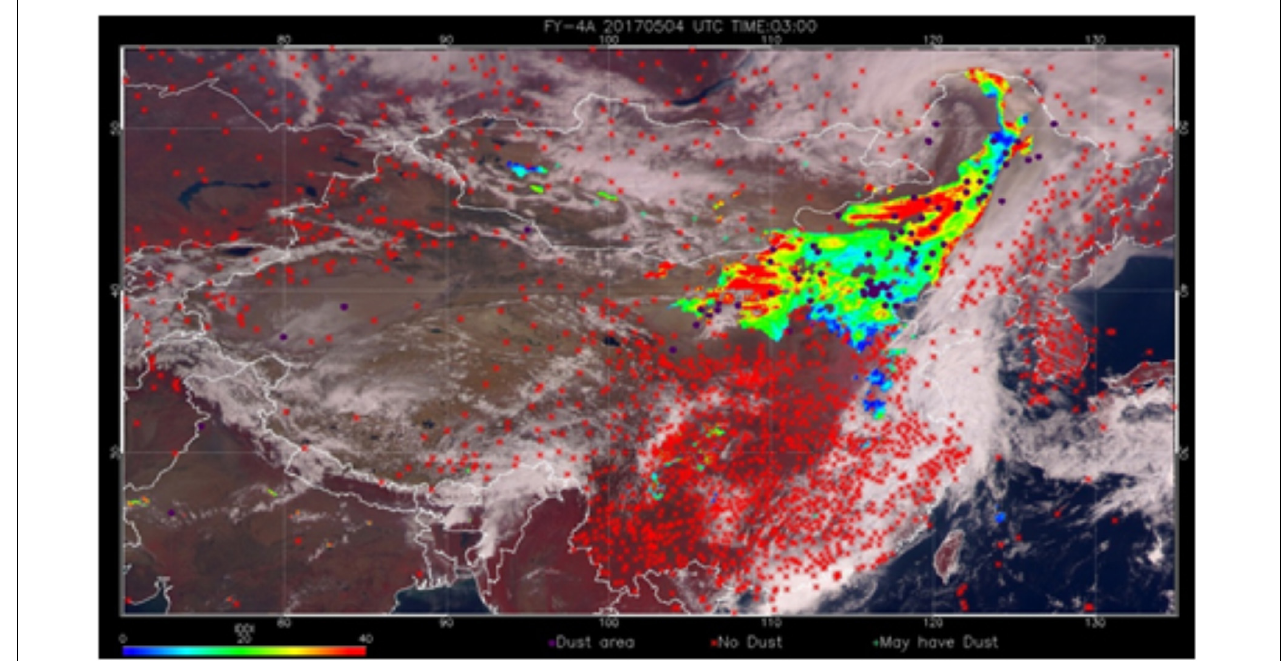
FIGURE 3 | Multi-channel composite image using FY-4A/AGRI 0.83, 0.65, and 0.47 µ m channels at 03:00 UTC 4 May 2017. Blue (red) dots represent ground observations of dust (no dust).